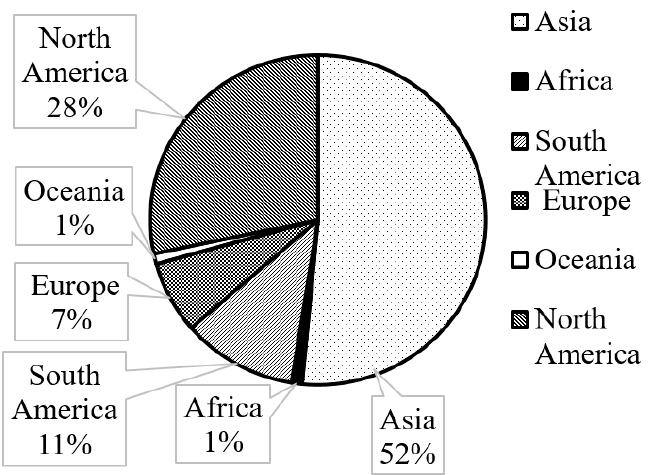
Figure 6. Regional distribution of the studies.